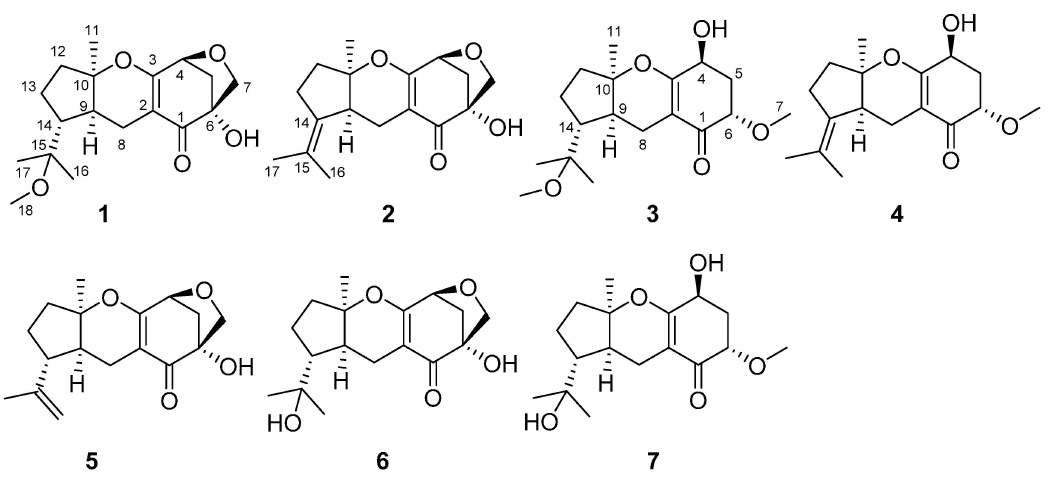
Figure 1. The chemical structures of compounds 1 – 7